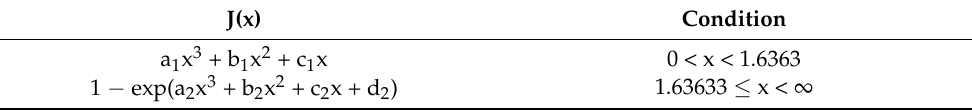
Table A2. J(x) used in I M ( γ ).